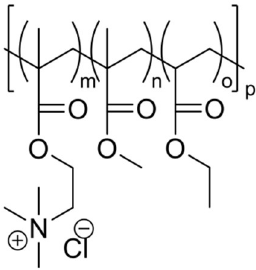
Figure 1. Chemical structure of Eudragit RS 100.